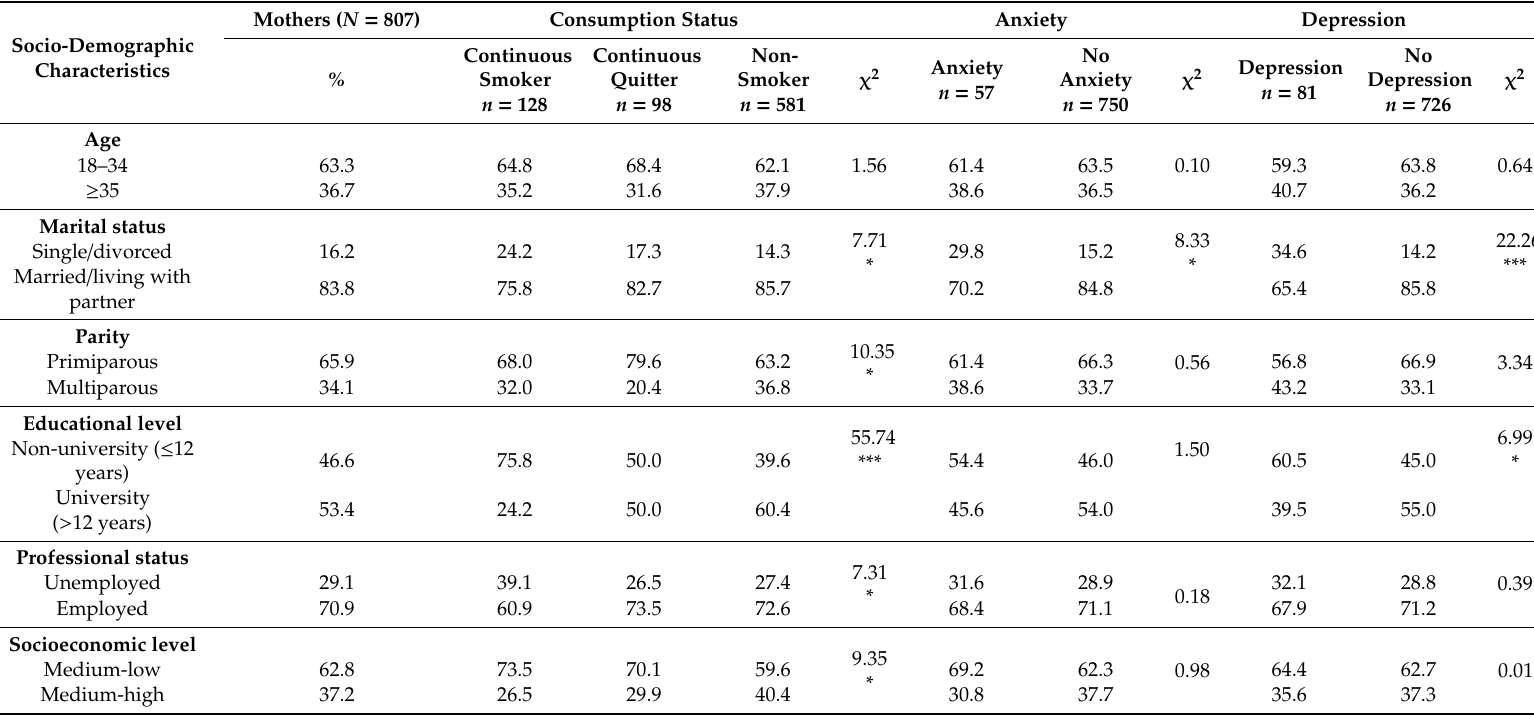
Table 1. Maternal socio-demographic characteristics, consumption status, anxiety and